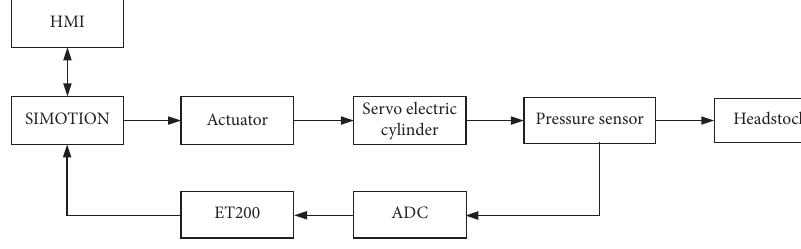
Figure 5: Test machine loading hardware system composition.